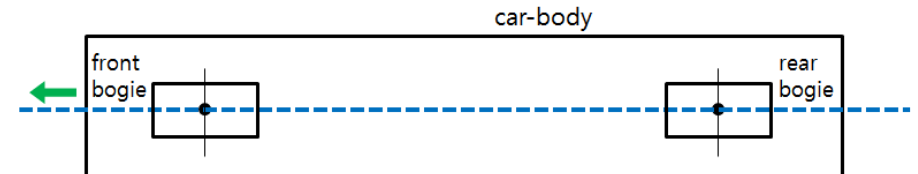
Figure 1. Position of car body and bogies in a straight